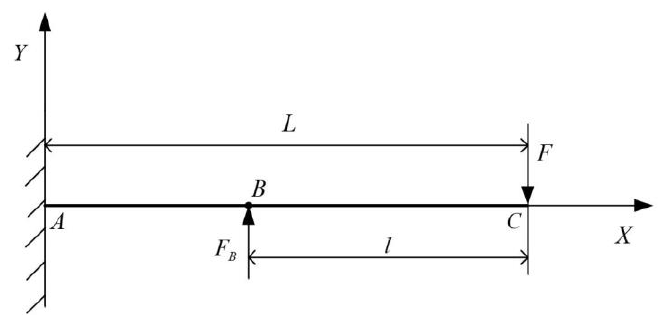
Figure 5. Schematic diagram of the cantilever beam under concentrated load.